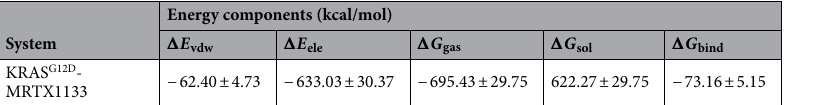
Table 2. Binding energy profile of MRTX1133 compounds. ΔE ele = electrostatic energy; ΔE vdW = van der Waals energy; ΔG bind = total binding free energy; ΔG sol = solvation free energy ΔG = gas phase free energy.